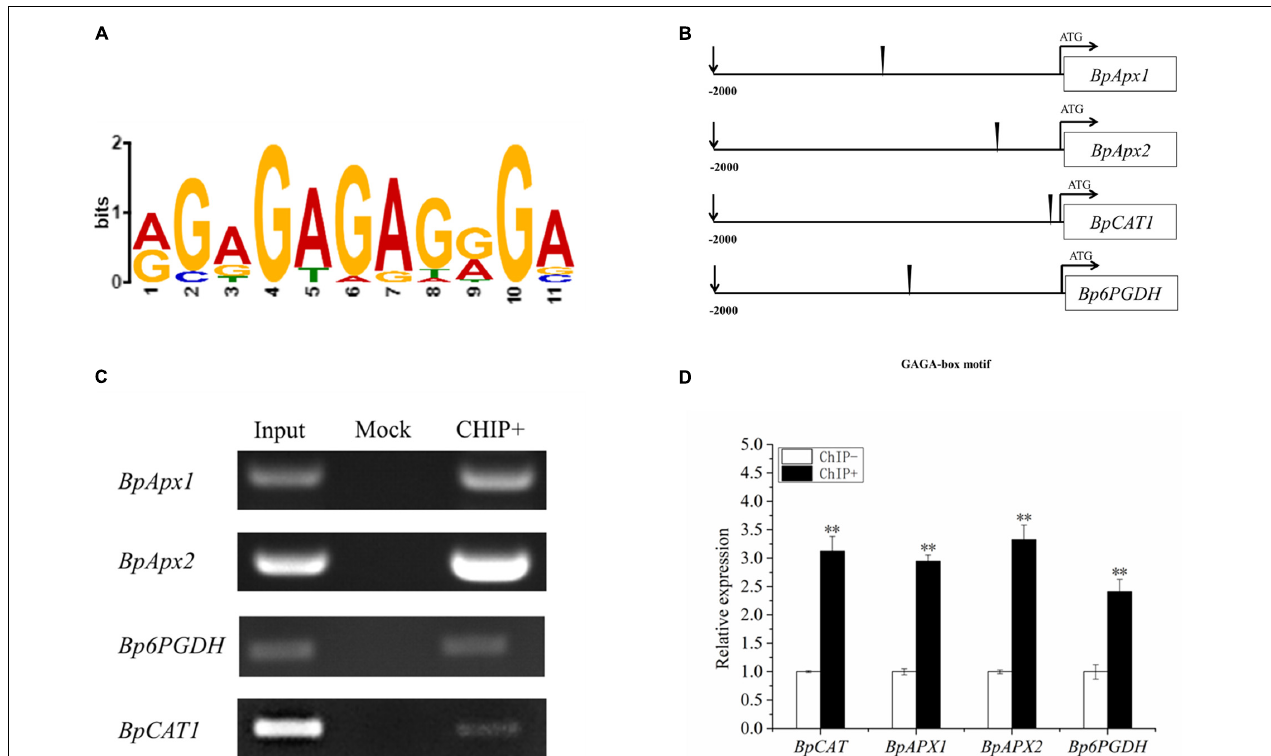
FIGURE 7 | (A) Multiple Expectation maximizations for Motif Elicitation (MEME) analysis of the conserved sequence GAGA-box present in the promoters of genes regulated by BpSZA1 . (B) The schematic diagram shows the positions of the GAGA-box in the promoters. (C) Enrichment of the promoters of genes containing GAGA-box. (D) ChIP-qPCR analysis shows enrichment of the promoter sequences of genes after ChIP. ChIP+: the sonicated chromatin was immunoprecipitated with GFP antibody; mock: the sonicated chromatin was immunoprecipitated with IgG2a; input: the sonicated chromatin was used as a positive control. Three biological replicates were performed. Asterisks denote significant differences: ∗∗ P ≤ 0.01. Error bars represent standard error for three replicates.